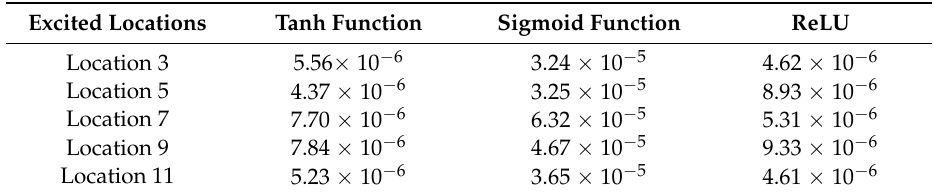
Table 13. Average validation errors (MSE) for virtual sensor using convolutional neural network in experiment example under different training load cases with different activation